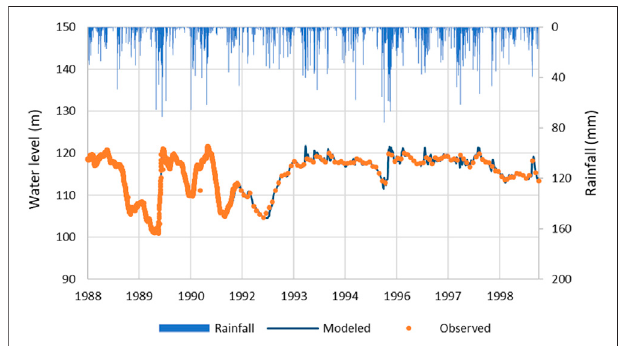
FIGURE 3 | Comparison between observed and modeled water level data.